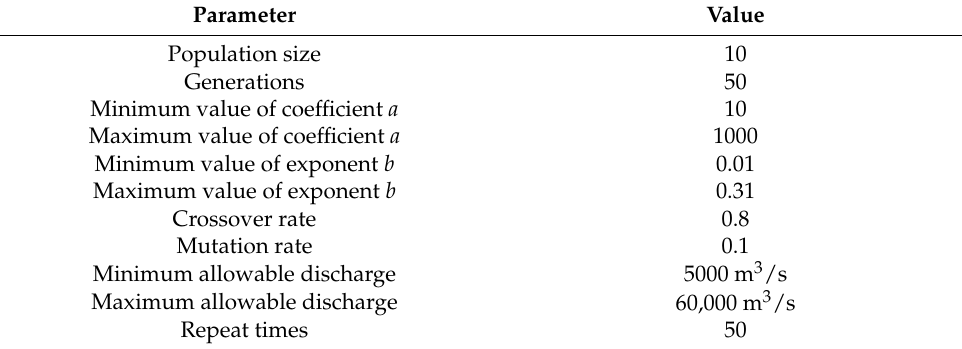
Figure 4. AMHG relationship of the Hankou. The black solid line is the AMHG fitted by the river widths and the gauged discharge, and the red dotted line is the AMHG solely fitted by the river widths. Table 2. Parameterization of the genetic algorithm used in this study.